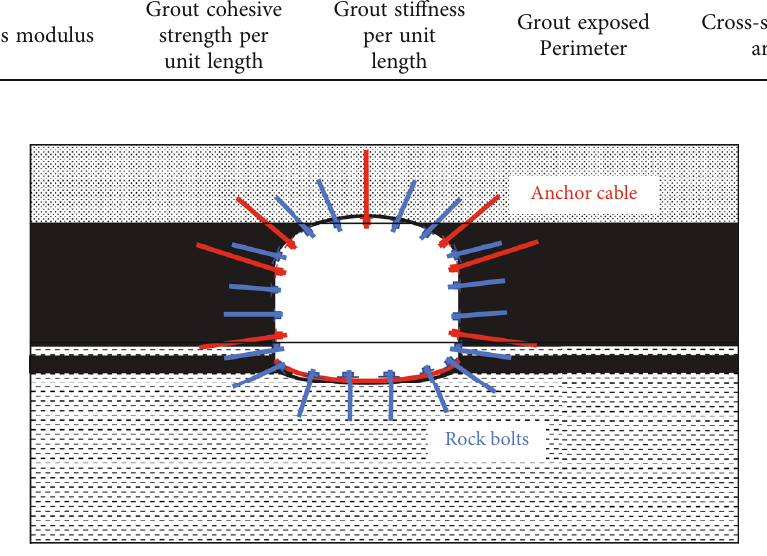
Figure 7: The diagram of cross-section support.